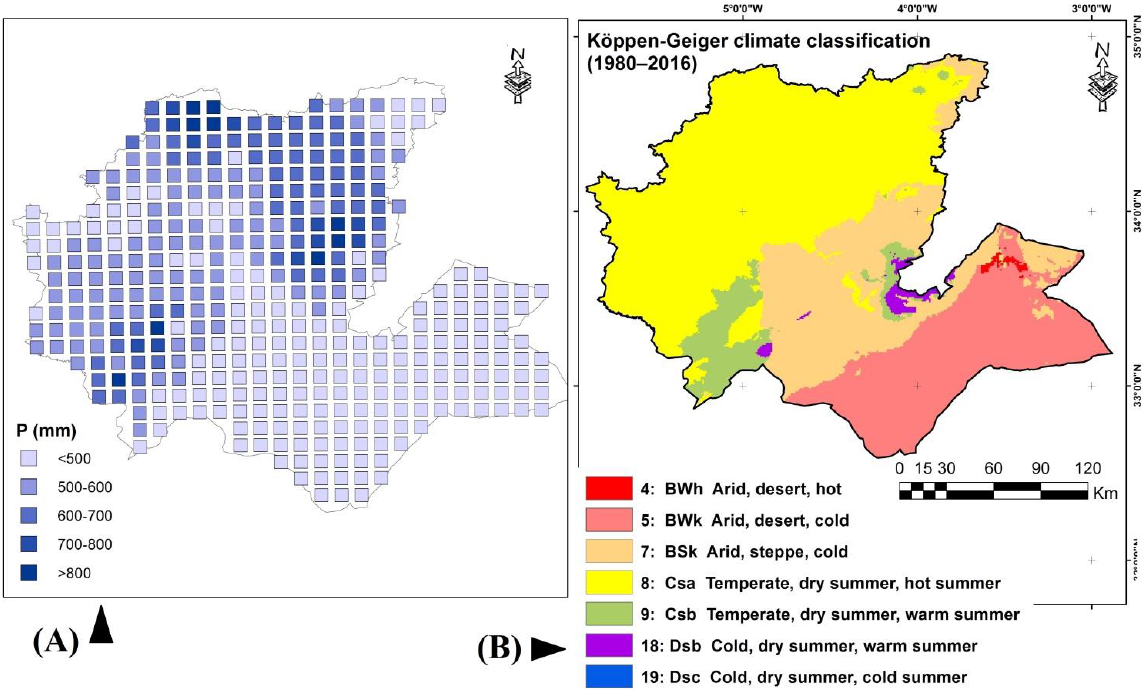
Figure 2. ( A ) Annual rainfall mean interpolated to the grid points, and ( B ) Köppen – Geiger climate classification based on the data from [40].